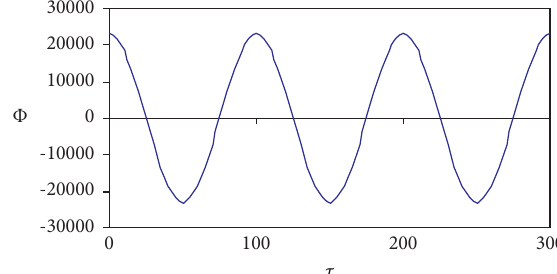
Figure 24: The stability phrase Θ ′ and Θ for case (ii) in Section 4.2.